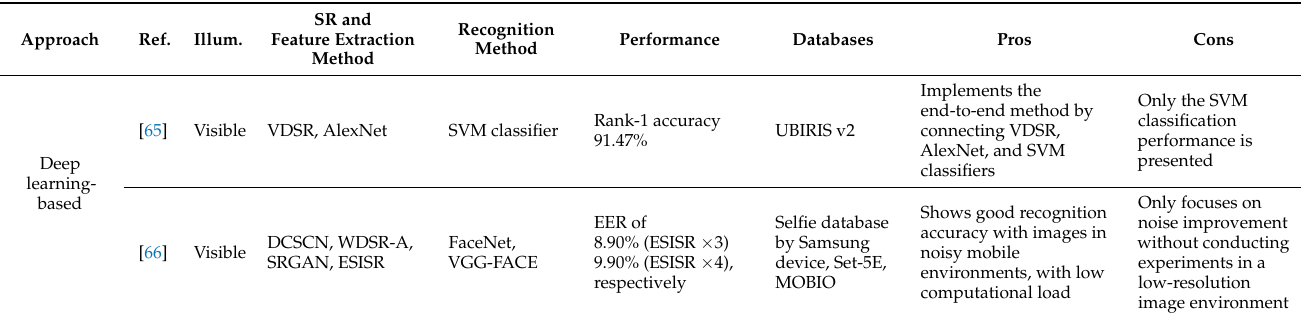
Table 4. Research into ocular recognition with low-resolution images (Ref. and Illum. denote reference and